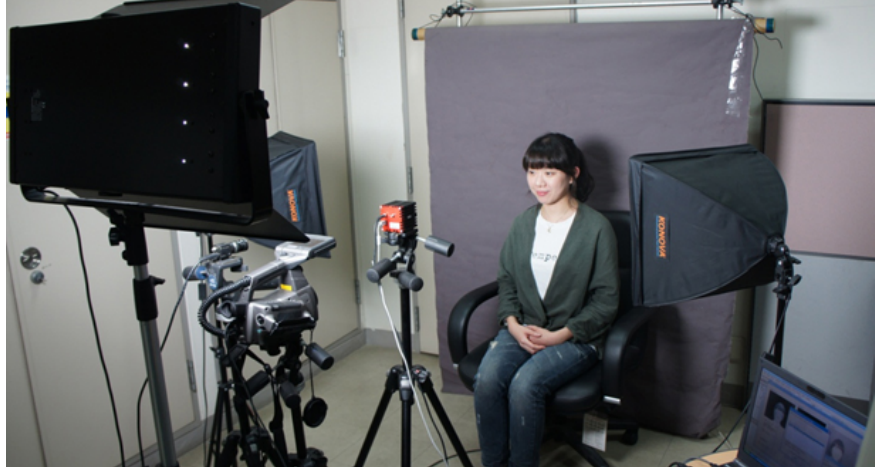
Figure 13. Experimental environments: three light sources and three different kinds of